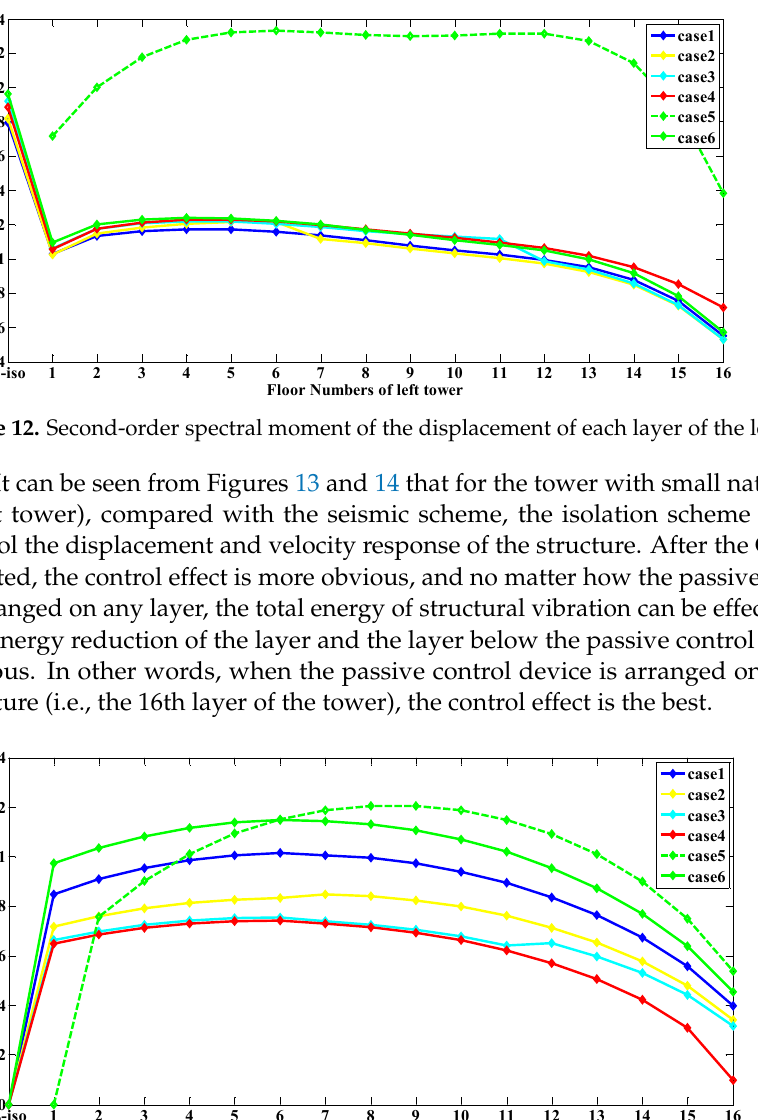
Figure 11. Zero-order spectral moment of the displacement of each layer of the left tower.